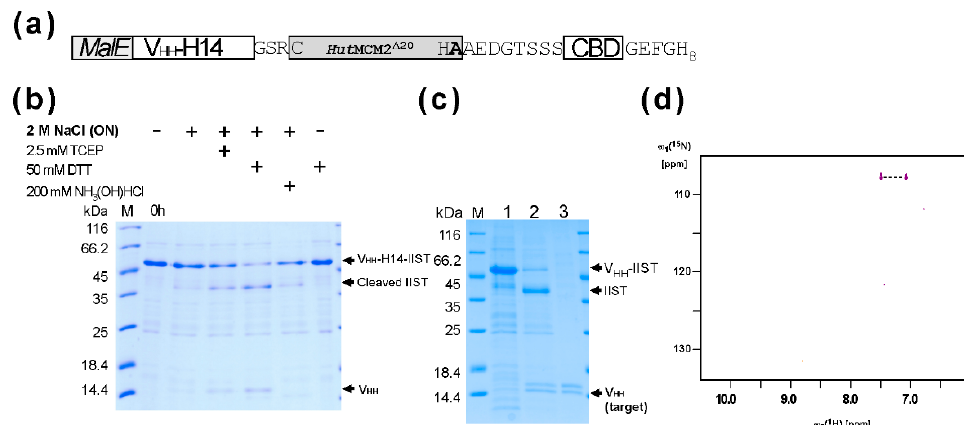
Figure 3. Purification and amidation of a model protein V HH -H14 using IIST. ( a ) The schematic structure of the fusion protein containing V HH -H14 with IIST for purification and amidation. ( b ) SDS-PAGE analysis of cleavages of the tagged protein under various conditions. ( c ) SDS-PAGE analysis of the amidation/cleavage and purification of V HH -H14. M stands for molecular weight markers. Lane 1, elution fraction from IMAC; lane 2, after incubation in the presence of the salt mixture; lane 3, the flow-through fraction from IMAC after salt incubation. ( d ) The [ 1 H, 15 N]-HSQC spectra of the cleaved and purified V HH -H14 after salt incubation using 15 N-labeled ammonium sulfate during the cleavage reaction. The dotted line connects two protons attached one 15 N atom in the C-terminal amide